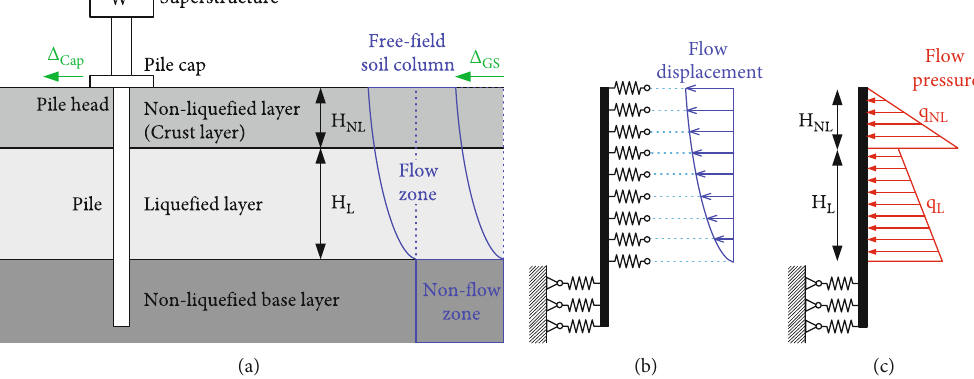
Figure 2: Actions of lateral spreading on pile. (a) Typical condition. (b) Modelled as fl ow displacement. (c) Modelled as fl ow Table 2. The SPT-N values of the reclaimed fi ll were mostly